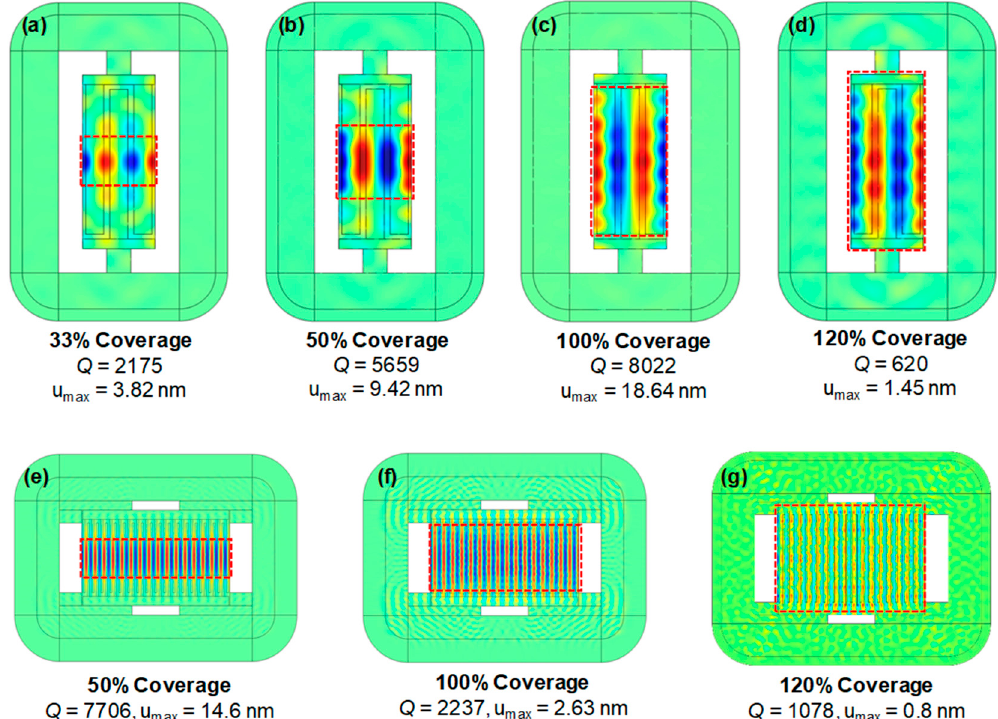
Figure 5. Contour images of vibration displacement fields of ( a – d ) Type D 230 MHz CMRs and ( e – g ) Type E 1.1 GHz CMRs with varying bottom electrode coverage rates.